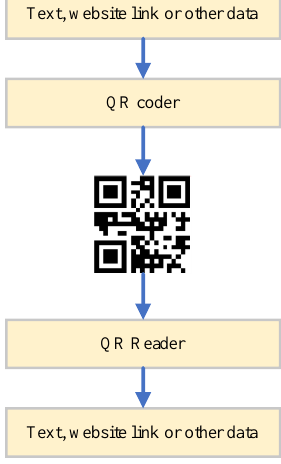
Figure 4. QR code system workflow chart.